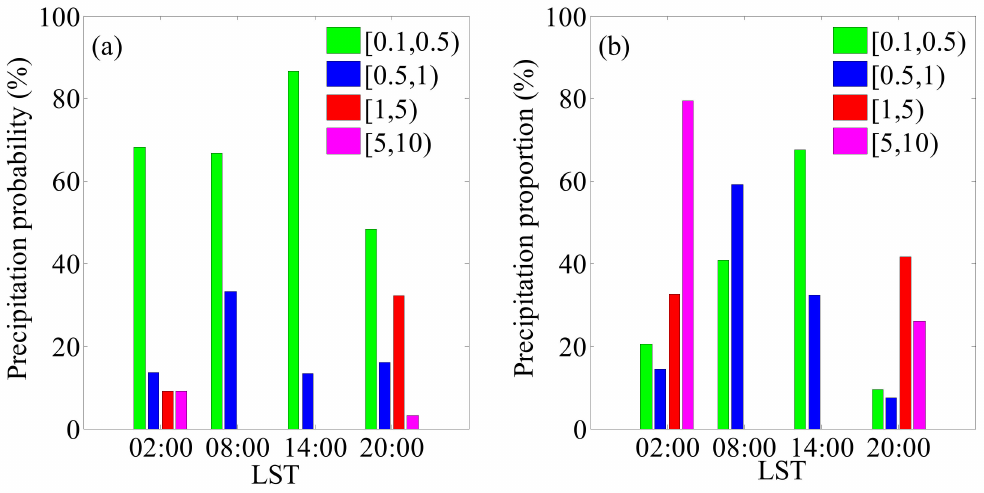
Figure 3. ( a ) Precipitation probability and ( b ) precipitation proportion in different grades at launch times in Jiulong